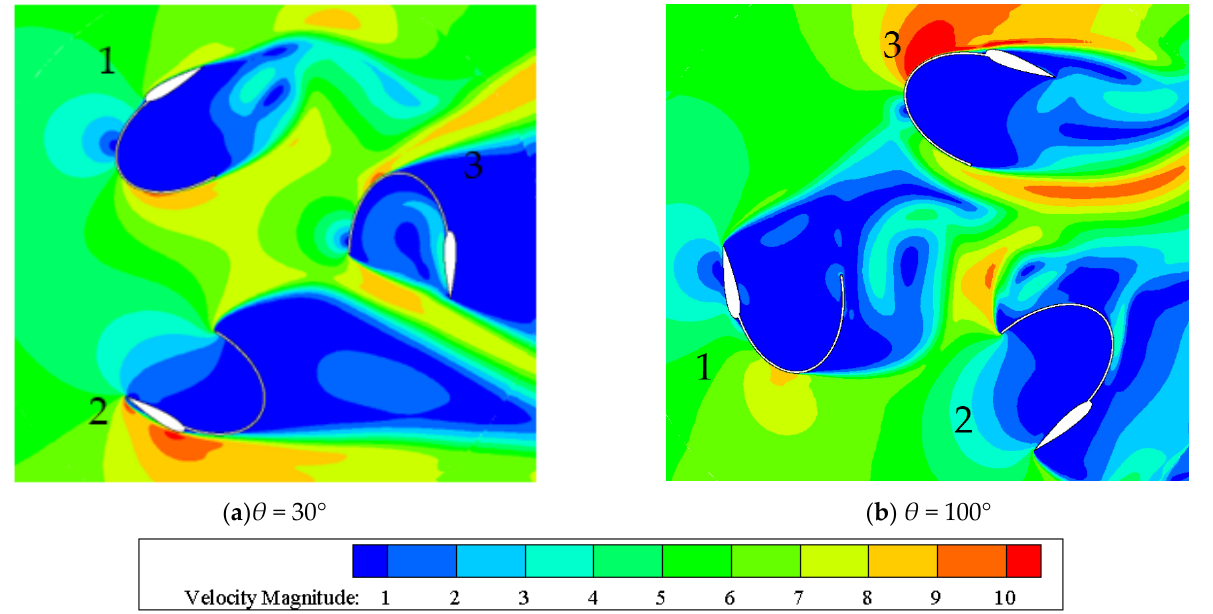
Figure 14. Velocity magnitude of 3-bladed LDCS ( U = 6 m/s): ( a ) θ = 30°: ( b ) θ = 100°. As shown in Figure 14a, the space between the blades was large when θ = 30 ◦ , and the three blades had convex parts that received the air coming from the wind. The